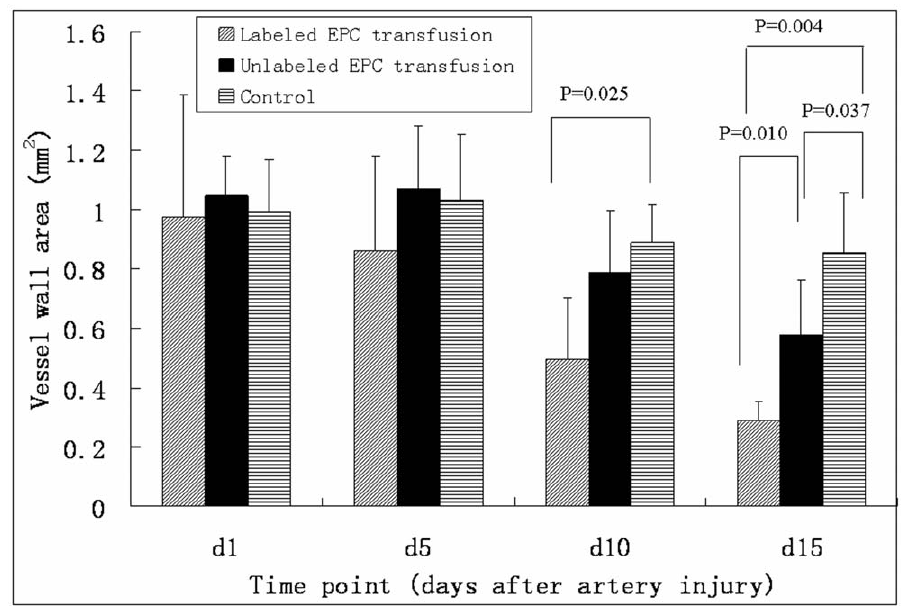
Figure 5. Vessel wall area (mm 2 ) of LCCA measured on T 2 WI at different time points. There was no significant difference of vessel wall area among the three groups 1 day and 5 days after artery injury. However, vessel wall area of labeled EPC transfusion group was significantly less than that of unlabeled EPC transfusion group and control group at 15 days after artery injury. Vessel wall areas of EPCs transfusion group were significantly less than that of non-EPC transfusion group at 15 days after artery injury.